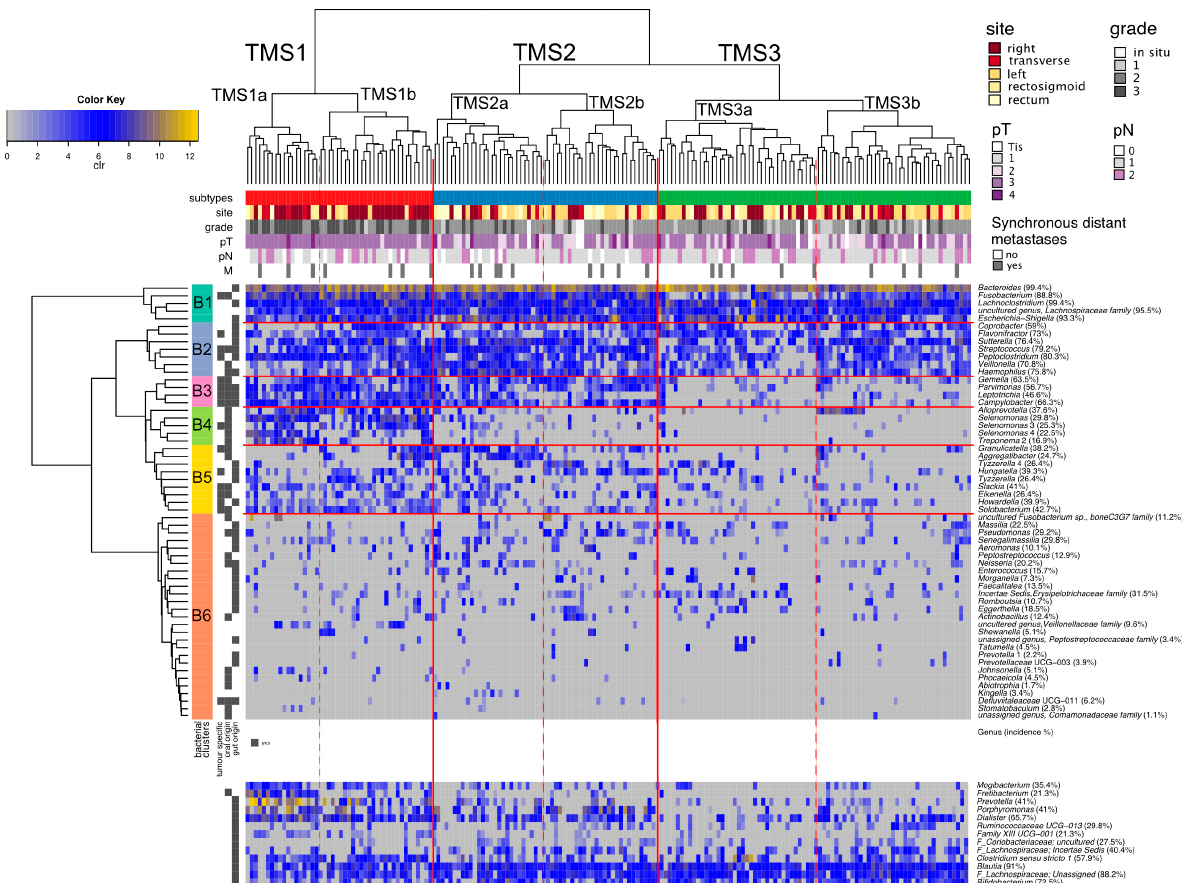
Figure 3. Tumour microbial subtypes. Hierarchical clustering of tumours (Aitchinson distance) and genera (Euclidean distance) based on the clr-transformed abundances of 57 tumour genera. Clinical variables of individual patients are shown. Proportions right to the genera name denote incidence of the genus in 178 tumour-mucosa samples. (TMS—tumour microbial subtypes, clr—centered log-ratio transformation, pT—tumour pathologic stage, pN—regional lymph nodes pathologic, M—synchronous distant metastasis, Tis—tumour in situ).